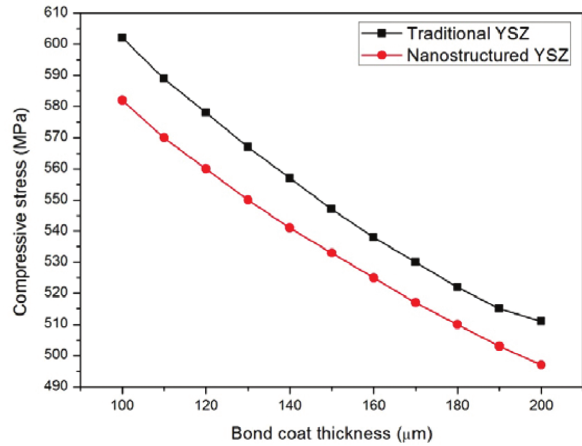
Figure 6: Axial compressive stresses in traditional and nanostruc- tured YSZ coatings as a function of bond coat thickness.